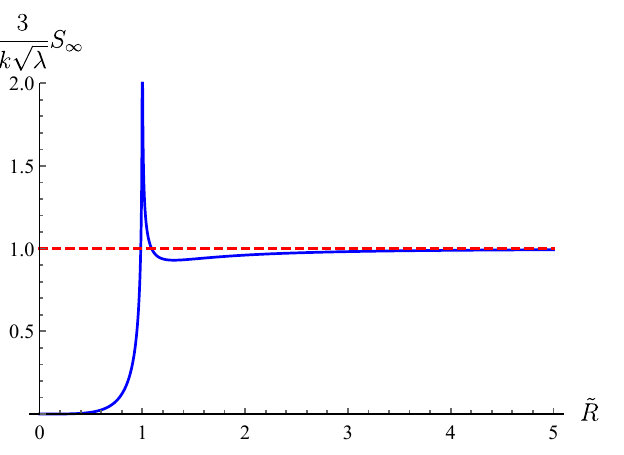
√ Figure 9 . Our result for S ∞ / ( k λ/ 3) from eq. (4.64) as a function of ˜ R ≡ R/R 0 , with R 0 ≡ κ/v fixed as κ → ∞ and v → ∞ . Clearly S ∞ diverges at ˜ R = 1 , and approaches k indicated by the horizontal dashed